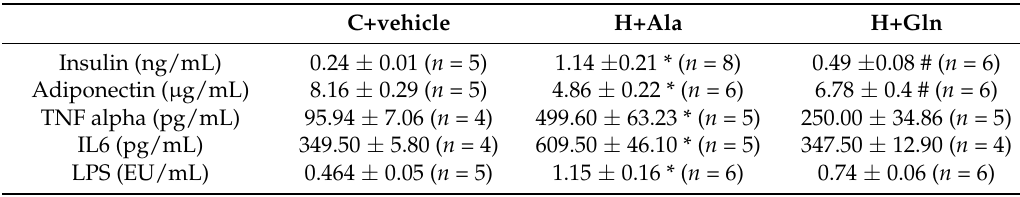
Table 3. Animal’s metabolic characteristics.